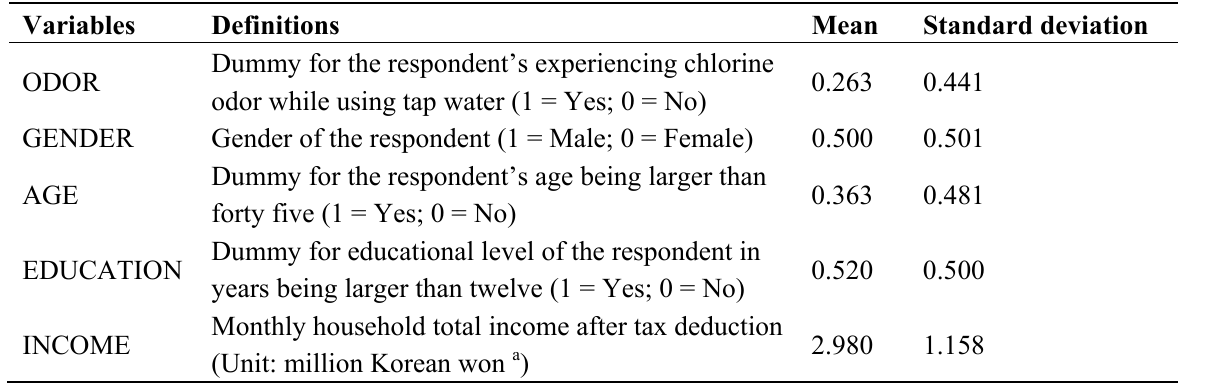
Table 3. Definitions and sample statistics of the variables.